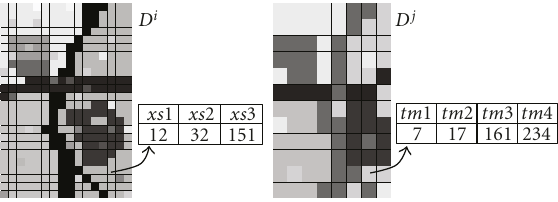
Figure 4: The three di ff erent cases of image